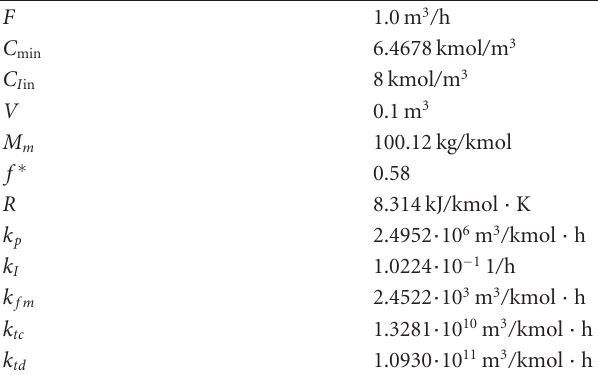
Figure 9: The economic performance in the base and improved case at di ff erent confidence levels. Table 1: Design parameters for MMA polymerization